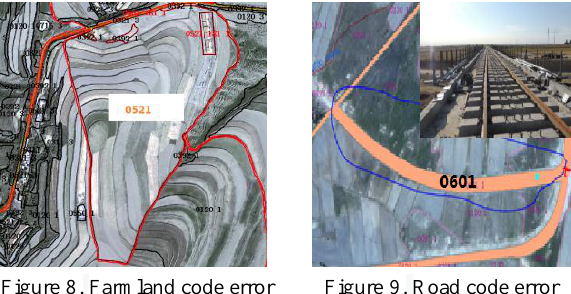
Figure 8. Farmland code error Figure 9. Road code